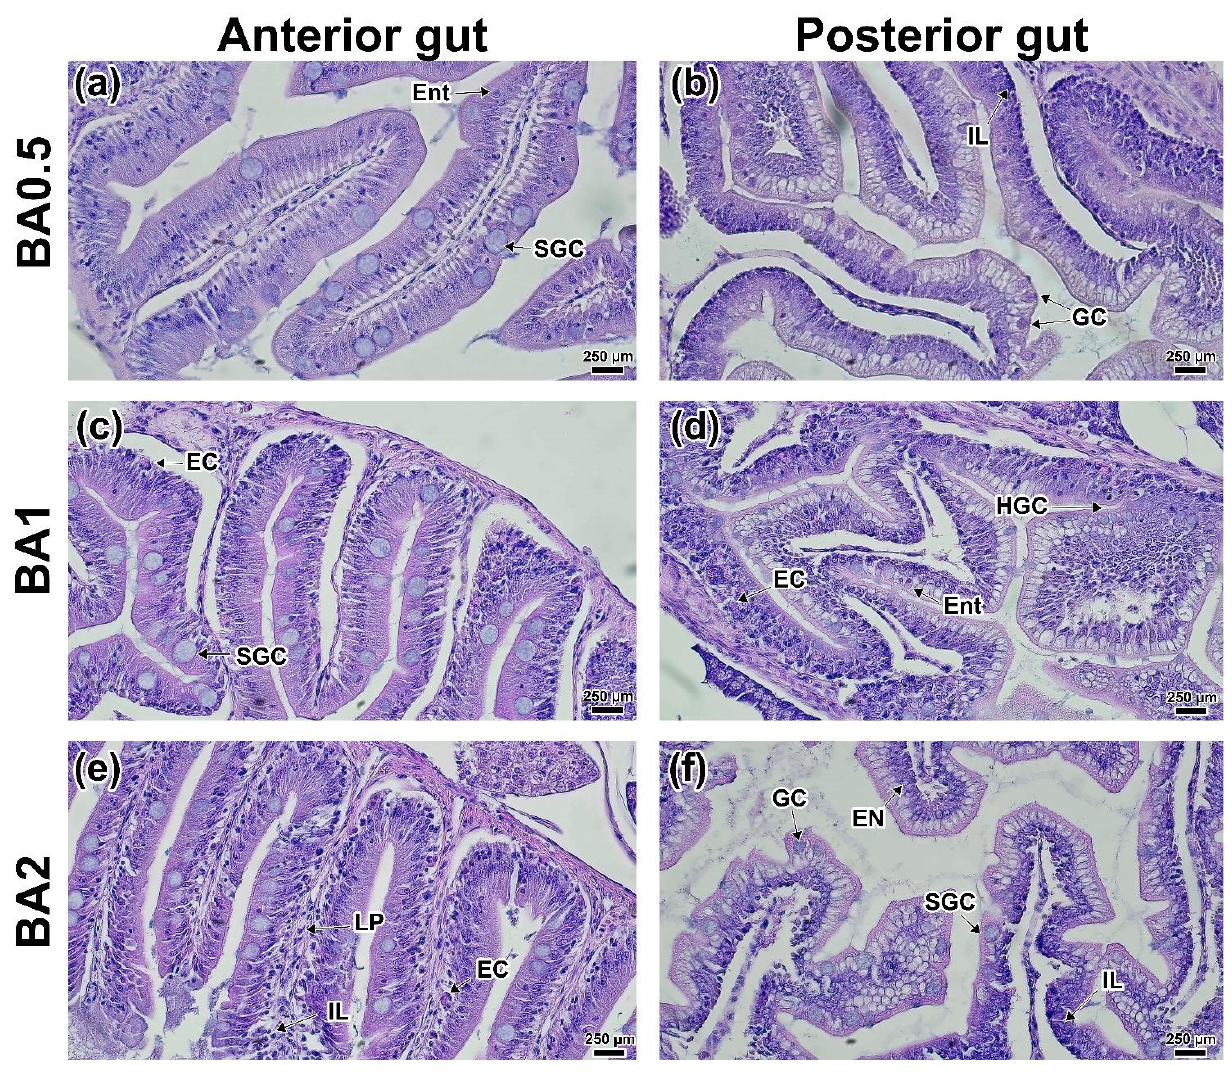
Figure 5. Histology of anterior ( a , c , e ) and posterior ( b , d , f ) intestines of the D. rerio experimental groups receiving butyric acid: ( a , b ) BA0.5 group; ( c , d ) BA1 group; ( e , f ) BA2 group. LP — Lamina propria; GC — goblet cells; EN — epitheliocyte nucleus/columnar pseudostratified epithelium; IL — intraepithelial leucocytes; EC — esonophilic/immune cells; Ent — basophilic enteroendocrine; SGC — swelling goblet cell. H&E staining, scale bar 250 µm.